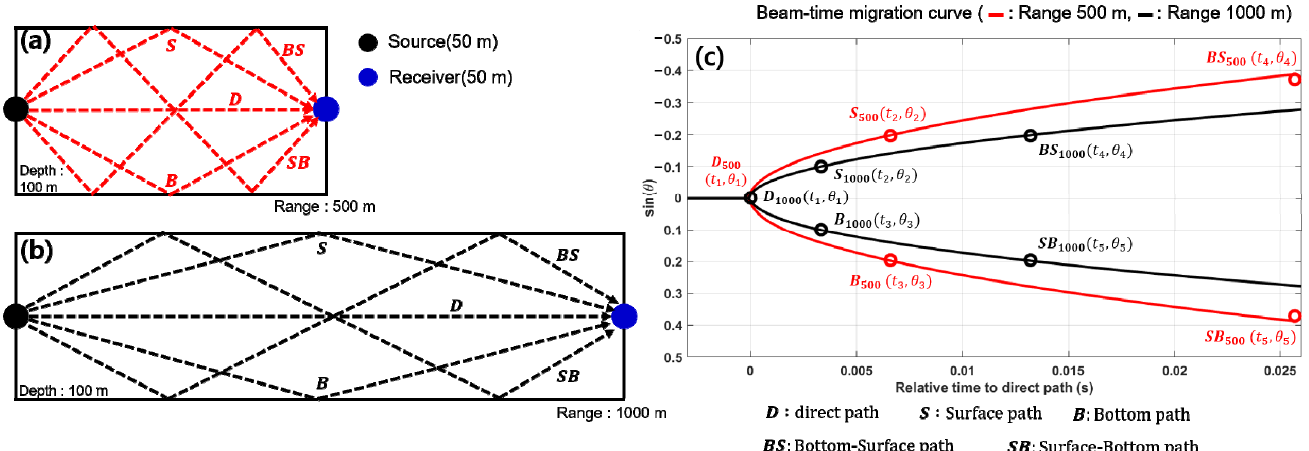
Figure 1. Eigenray outputs for source–receiver ranges of ( a ) 500 m and ( b ) 1000 m, and ( c ) beam-time migration curves for the multipaths of source-receiver ranges 500 m and 1000 m.